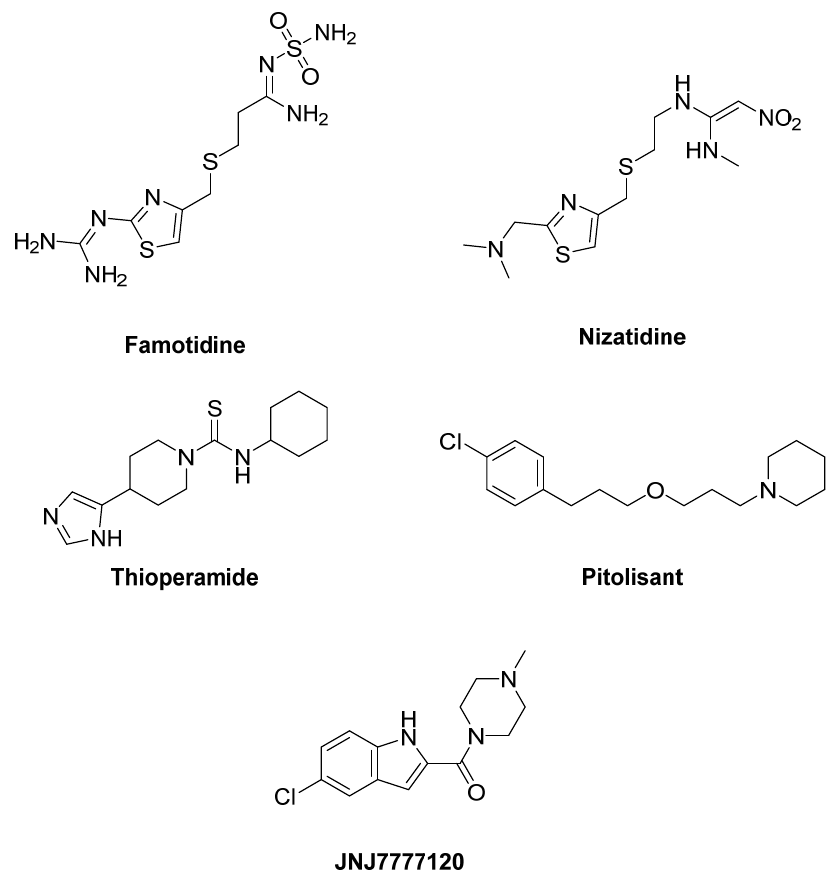
Figure 12. Histamine receptor